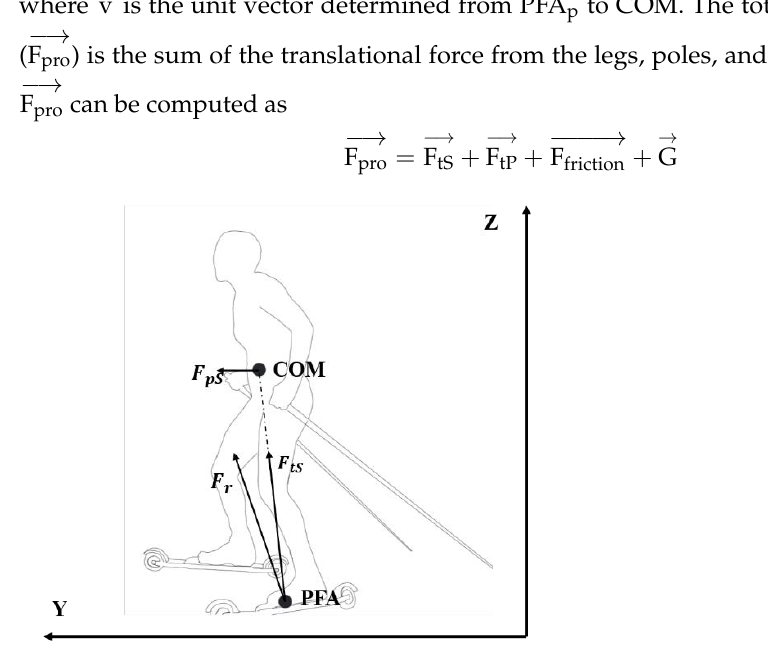
Figure 4. Diagram of force decomposition from skis. F r is the resultant force generated from legs. F tS is the translational component, which went through the COM. F pS represents the propulsion generated from legs in the forward direction.